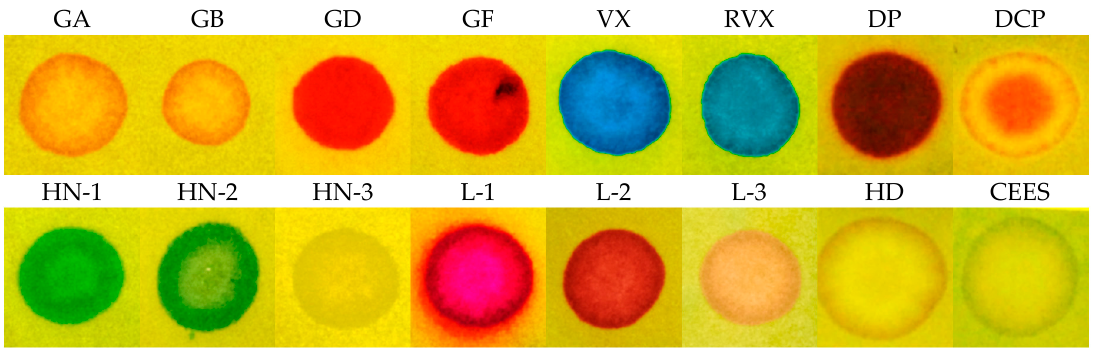
Figure 6. The Bromocresol Green (BCG) color change mechanism scheme. Chemosensors 2019 , 7 , x FOR PEER REVIEW